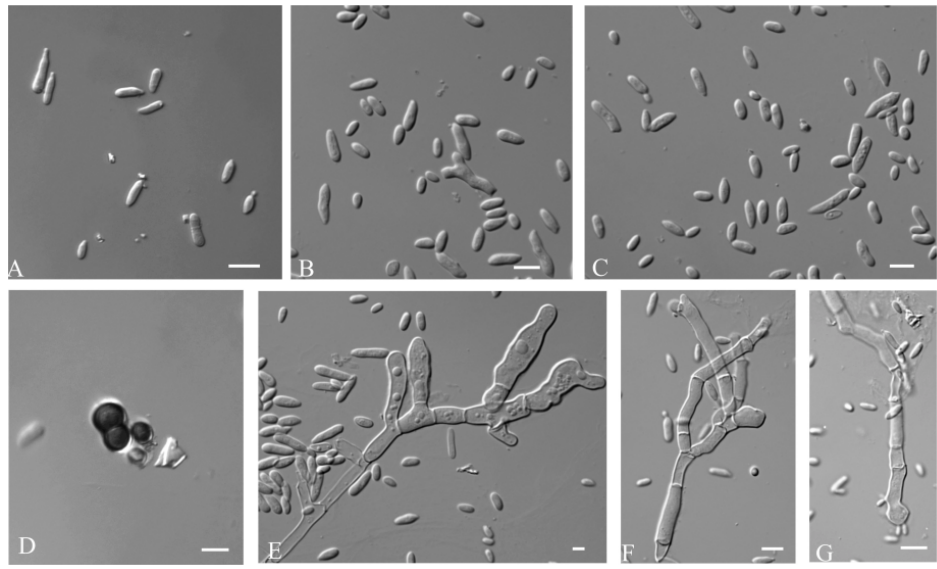
Figure 3. A. insectorum (CGMCC 2.7207- ex-type-culture). ( A – C ): Conidia. ( D ): Chlamydospores. ( E